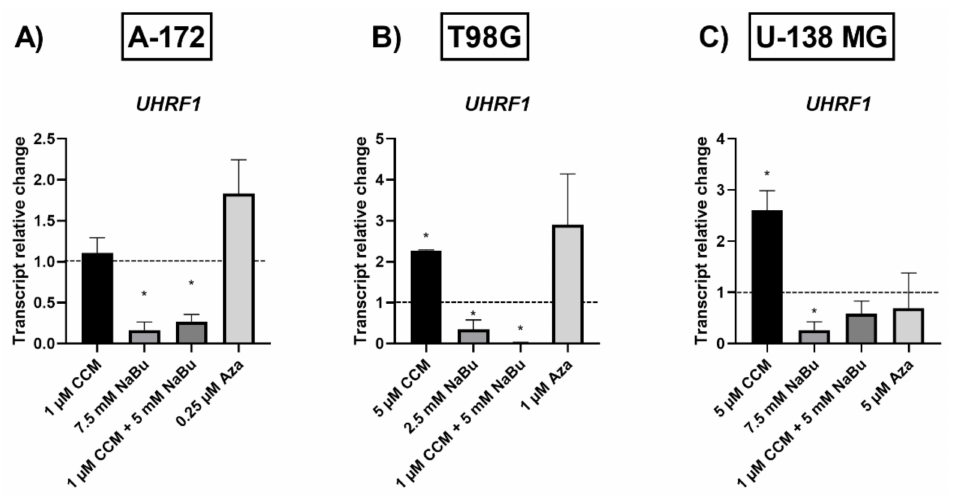
Figure 8. Transcript relative change of epigenetic regulator UHRF1 in A-172 ( A ), T98G ( B ), and U-138 MG ( C ) cells after treatment with CCM, NaBu, combination treatment of CCM & NaBu, and Aza. Data are presented as mean values ± SEM from two independent experiments. Control equals 1 and is indicated with a horizontal line. (*) above bar indicates statistically significant differences from control group, p <